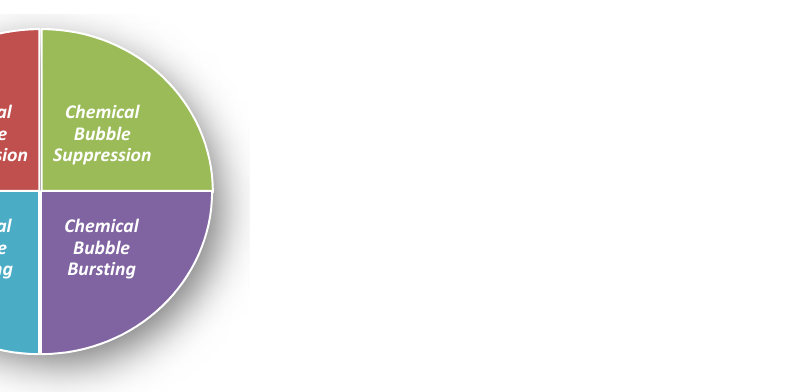
Figure 3. Four kinds of defoaming methods. Physical Bubble Suppression: Temperature change [22]; filtering to remove floating materials [21]; making the vessel open, to remove the mechanical foaming factors (to avoid violent boiling, oscillation, decompression, splashing). Physical Bubble Bursting: Temperature change [22] (freezing, heating [23], evaporation, drying); pressure change [24] (ultrasonic wave [25] and air injection); liquid injection; stirring and tapping with a hydrophobic metal mesh. Chemical Bubble Suppression: Adding defoaming agents; adding defoaming gases; using low foaming surfactants; adding electrolytes; adding substances that eliminate foam stability [21]. Chemical Bubble Bursting: Addition of electrolytes or by electrolysis to weaken the repulsion of the double electrical layers, adding substances discharging liquid [21]; salting out [26].